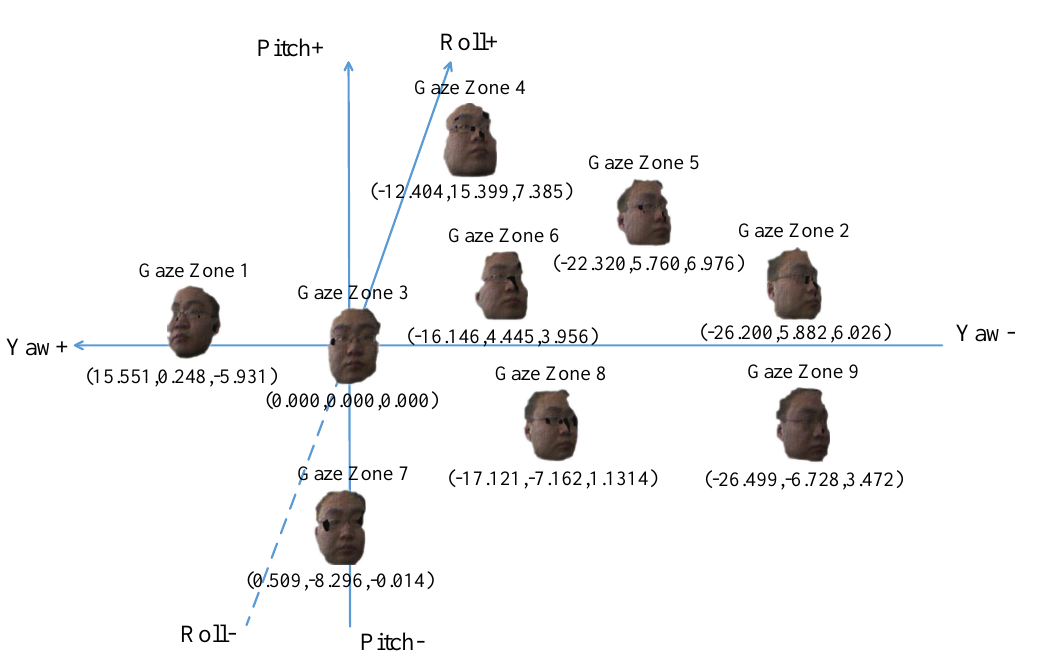
Figure 9. Point-cloud templates of different gaze